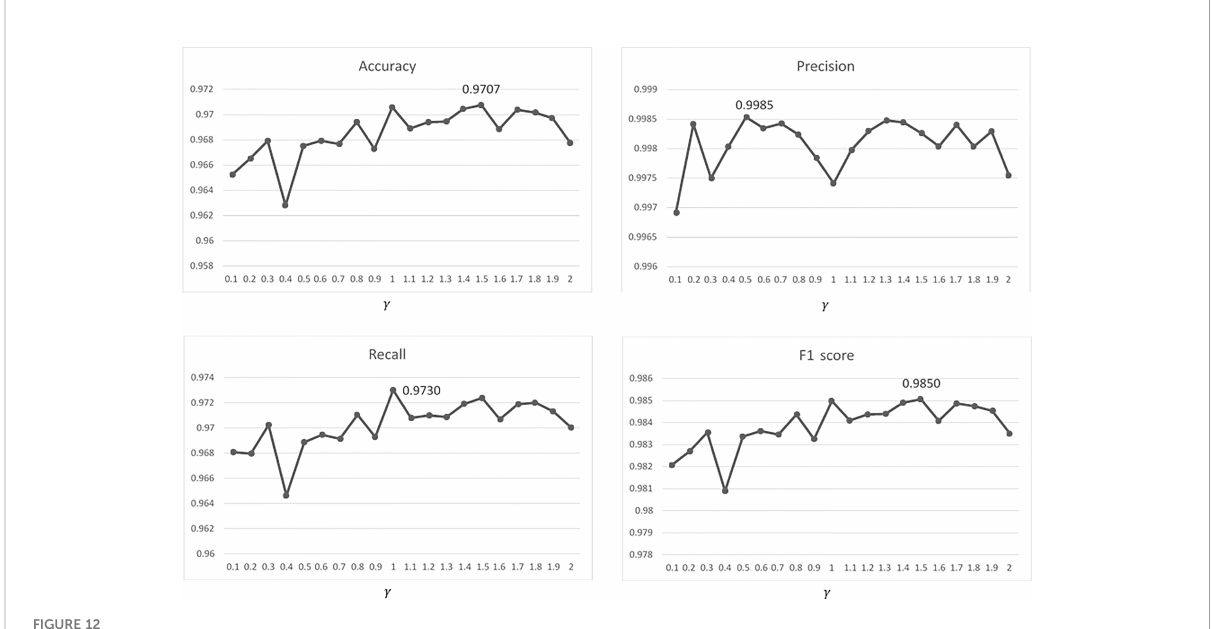
FIGURE 12 Performances of the leaf segmentation versus different values of gamma ( g